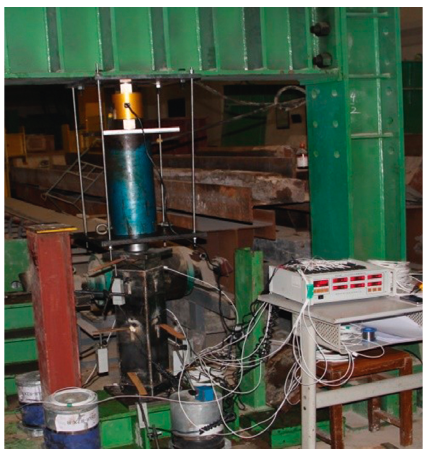
Figure 5: Actual loading picture.